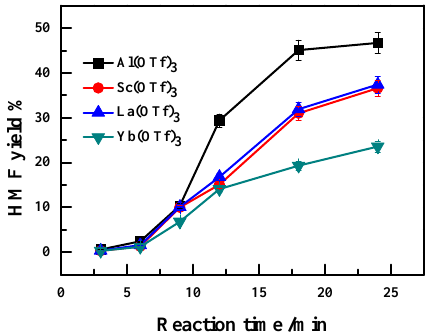
Figure 2. Effect of ionic radii of Lewis acid salts on the yield of HMF. Reaction conditions: reaction temperature of 160 °C, reaction time of 25 min, 0.1 g glucose in 1.5 g 25 mM Lewis acids aqueous solution, 3 g sec-butyl phenol.